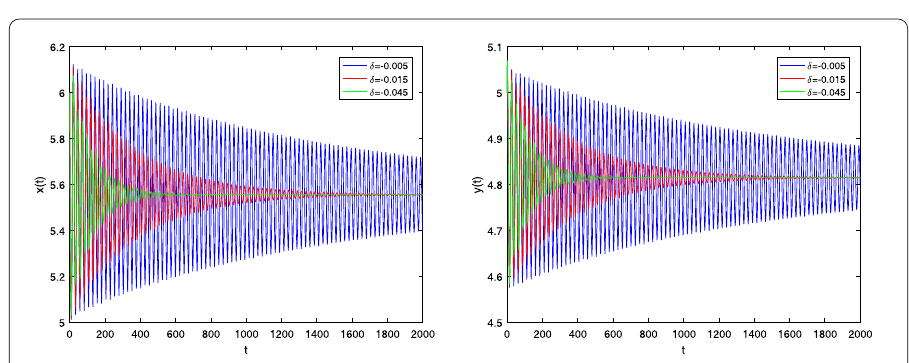
Figure 7 Waveform plots of system (4.24) with initial values (6.46,5.1) in Example 2. This figure illustrates the control effects the pulse width p = 5 and three different control gain δ =